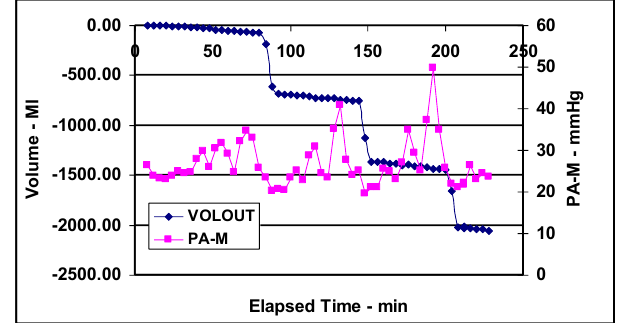
Figure 2. Mean pulmonary arterial pressure (PA-M) and simulated hemorrhage (VOLOUT) vs elapsed time. PA-M is not affected by the amount of bleeding prior to the first bleeding.